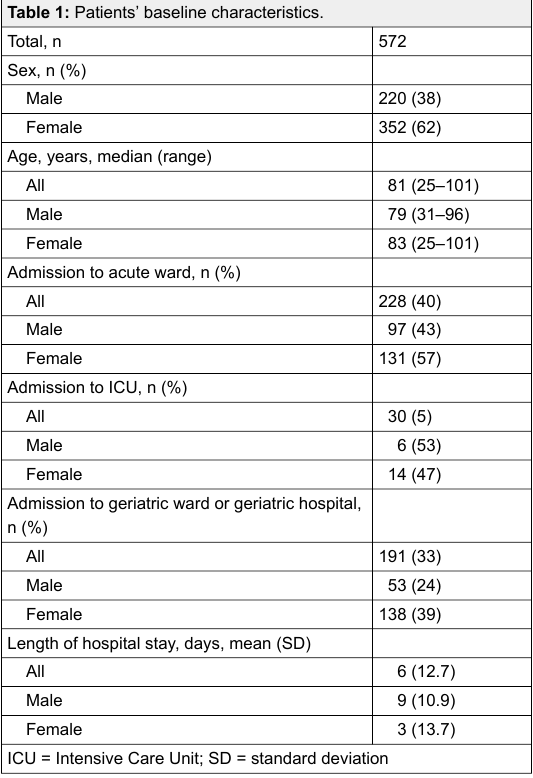
Table 1: Patients’ baseline characteristics.